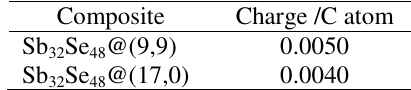
crystals with two different 3